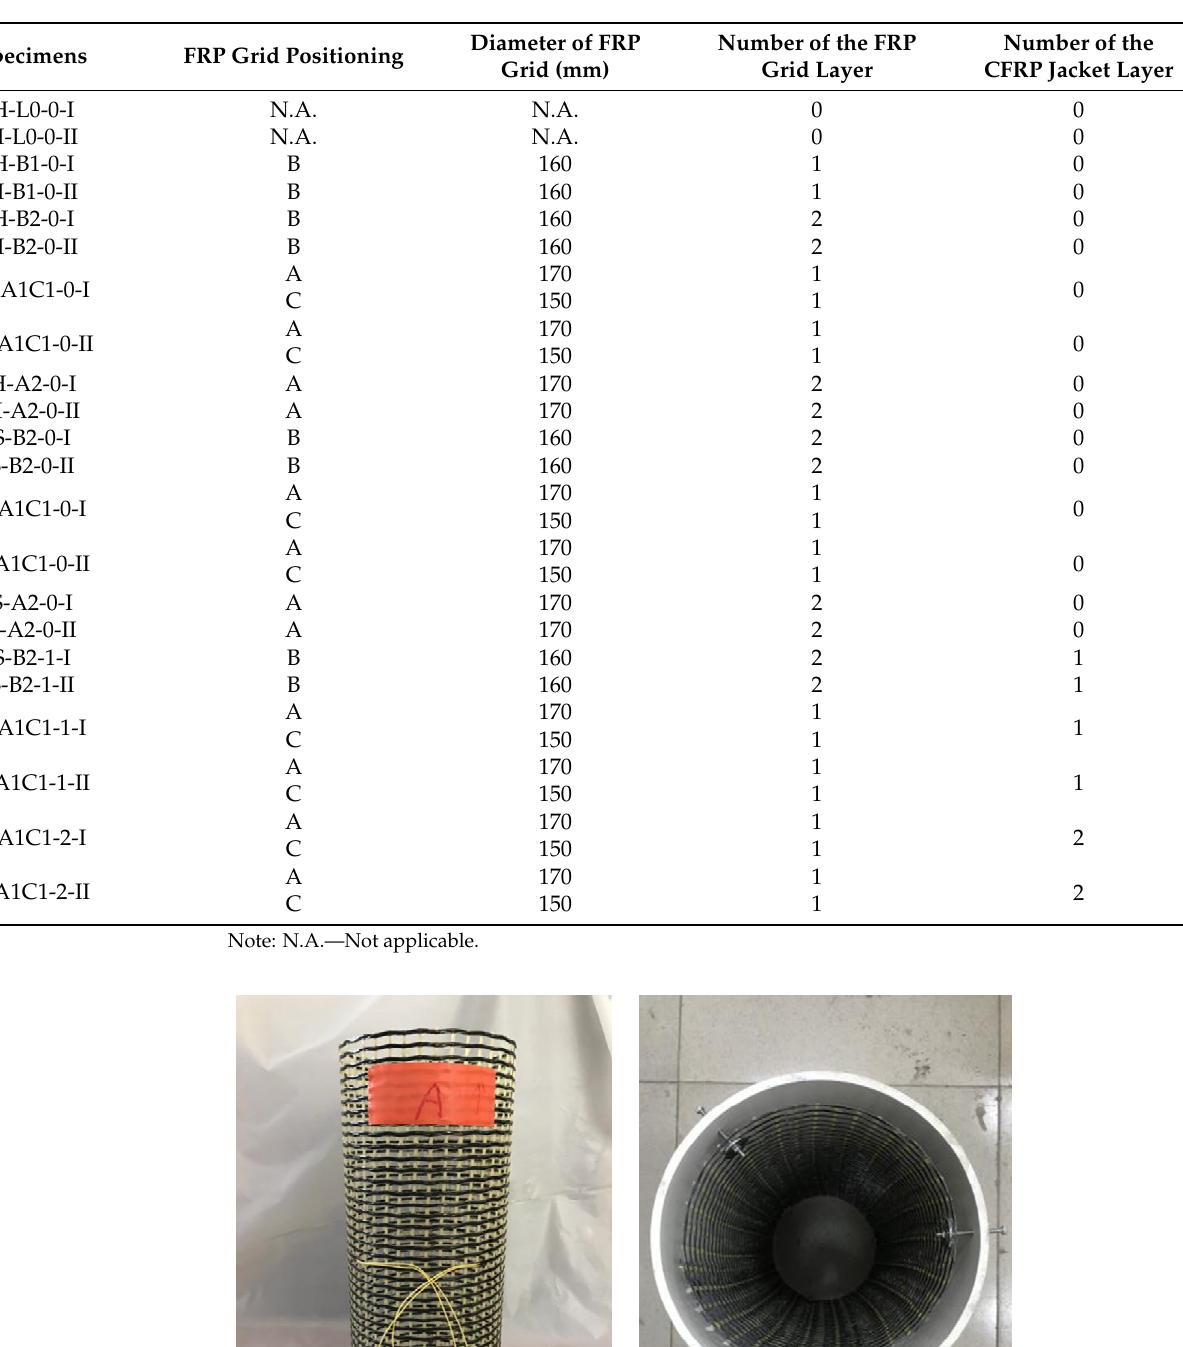
Table 1. Details of test specimens.